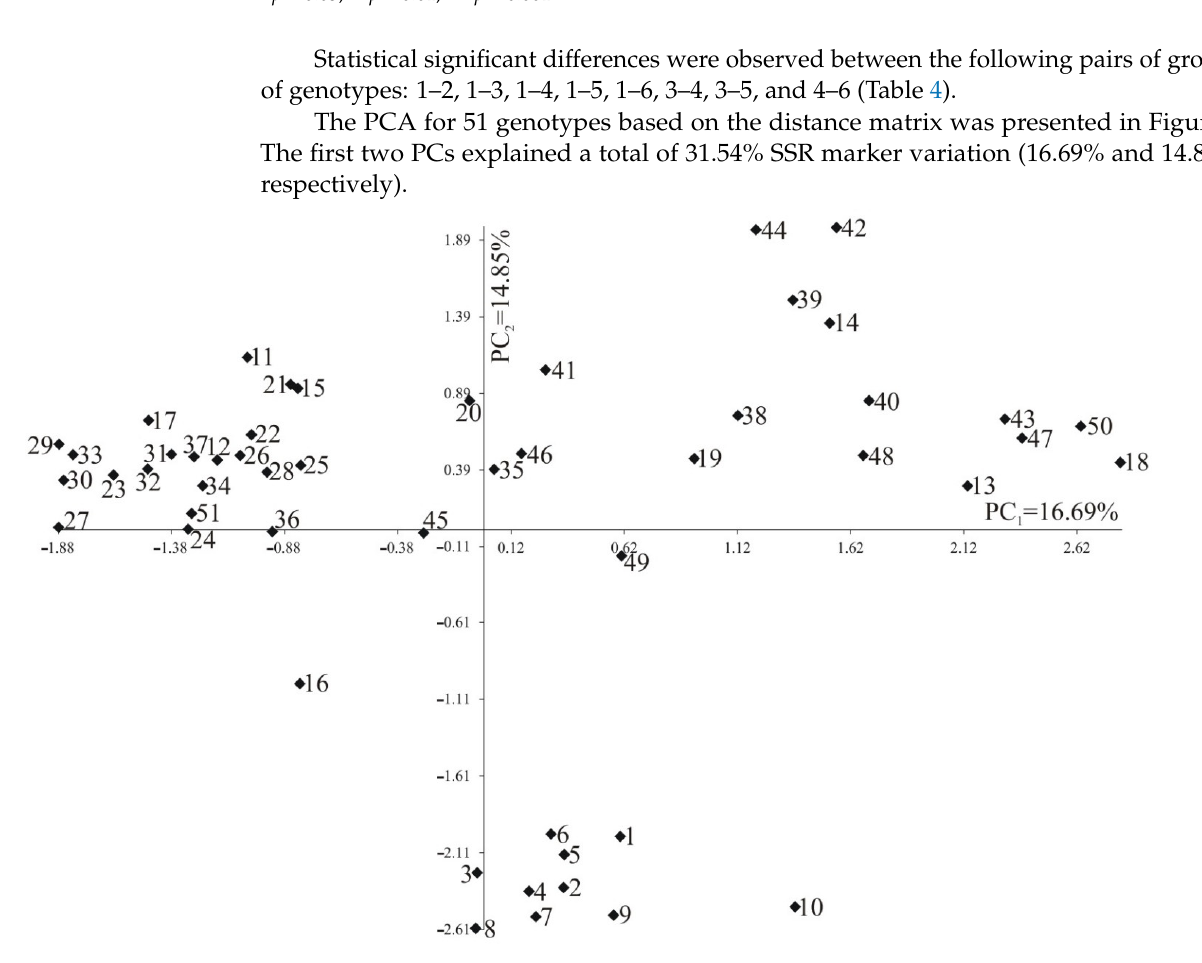
Figure 3. Principal component analysis of 51 genotypes based on 100 detected PCR products, numbers 1–51 according to Table 1.